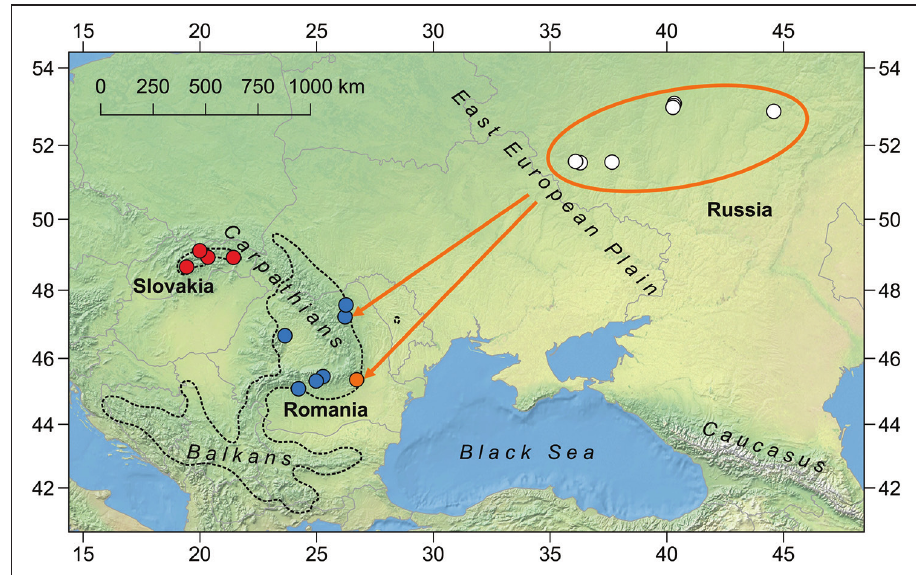
Figure 1. Sampled sites of Pholidoptera frivaldszkyi populations in Central and Eastern Europe. Three geographically homogeneous genetic clusters in the Carpathian Mountains defined by spatial analysis of molecular variance are colour coded according to Kaňuch et al. (2014). Arrows denote sites in eastern Romania where individuals that share the most similar haplotypes to populations found in Russia (ellipse) have occurred (see Fig. 2). The species range validated by the IUCN Red List (Hochkirch et al. 2016) is outlined by the dotted